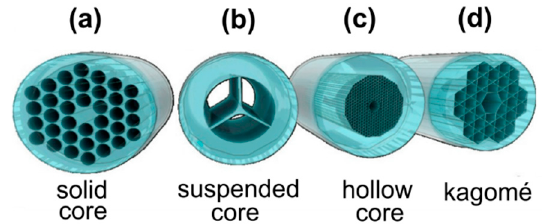
Figure 3. Illustration showing the different types of microstructured optical fiber-based sensors (MOFs): ( a ) Solid-core MOF, ( b ) suspended-core MOF, ( c ) hollow-core (HC)-MOF, ( d ) Kagomé HC-MOF. Reproduced with permission from [12].